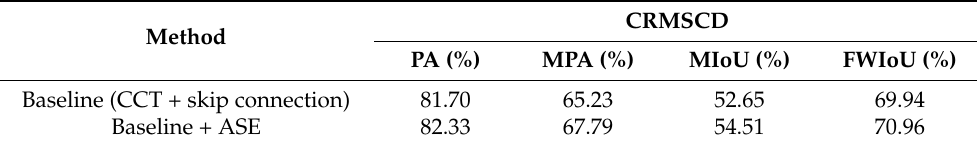
Table 10. Ablation experiments of ASE on encoder–decoder